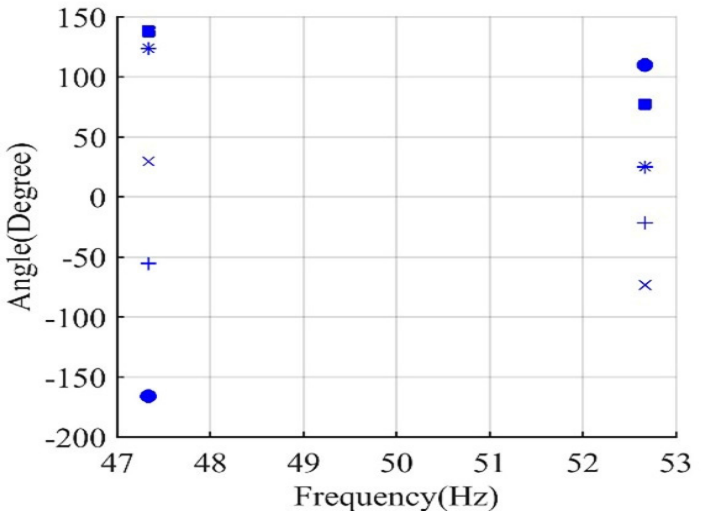
Figure 9. Motor I vector representation of left sideband and right sideband components for; adjacent